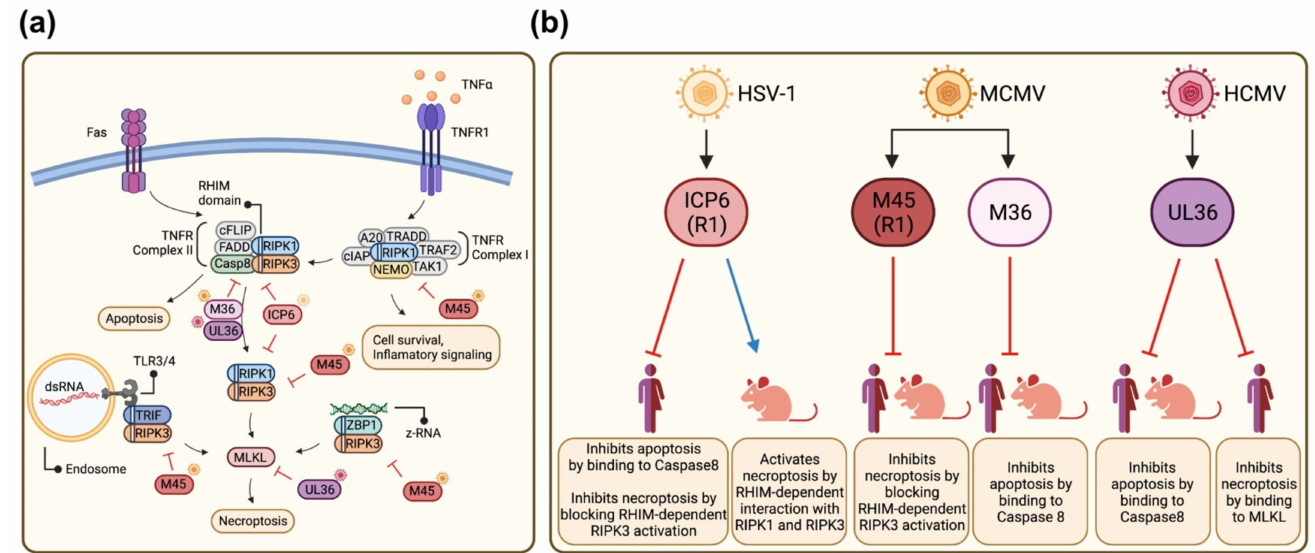
Figure 1. Inhibition of apoptosis and necroptosis by HSV-1, HCMV, and MCMV. ( a ) Schematic representation of death receptor-dependent (extrinsic) apoptosis and necroptosis signaling pathways. The viral inhibitors (marked with virus symbols) and their targets are shown. ( b ) Known functions of the viral cell death inhibitors in human and murine cells. Figure generated with BioRender.com (accessed on 21 October